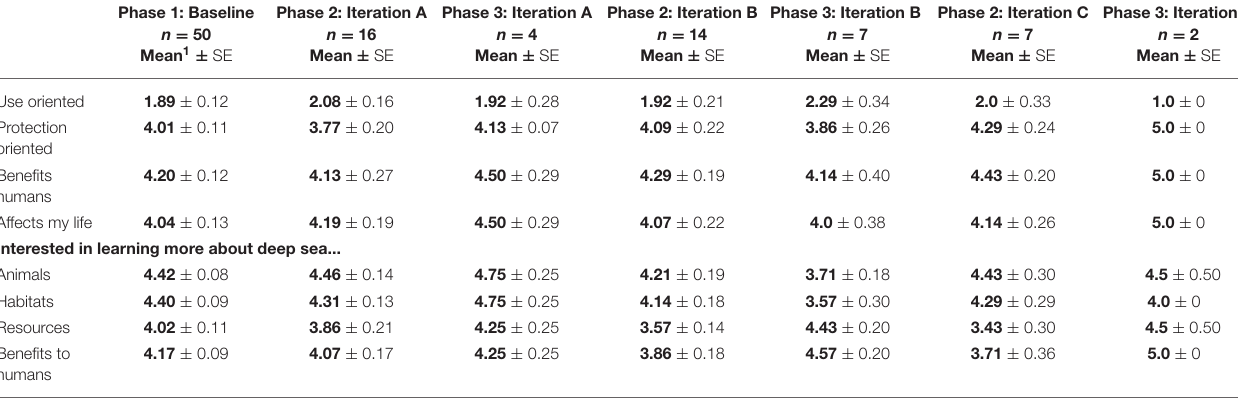
TABLE 2 | Visitor assigned value and perception toward Oregon’s deep